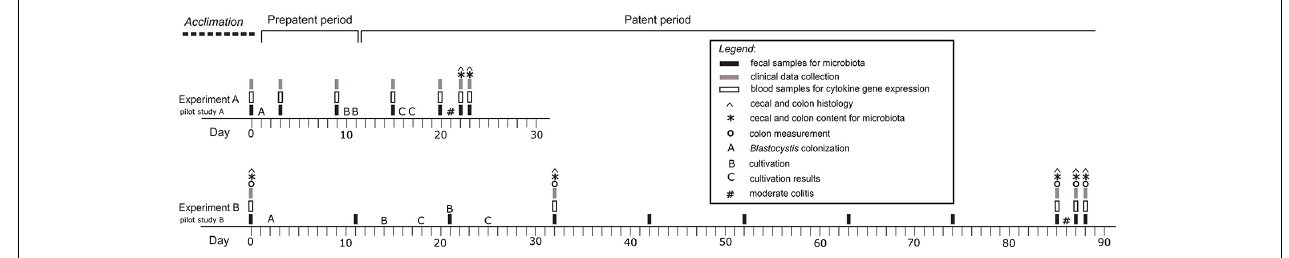
FIGURE 1 | Graphical design of the experiments and pilot studies. Experiment A – the short-term Blastocystis ST3 colonization (i.e., 3 weeks); Experiment B – the long-term Blastocystis ST3 colonization (i.e., 13 weeks).